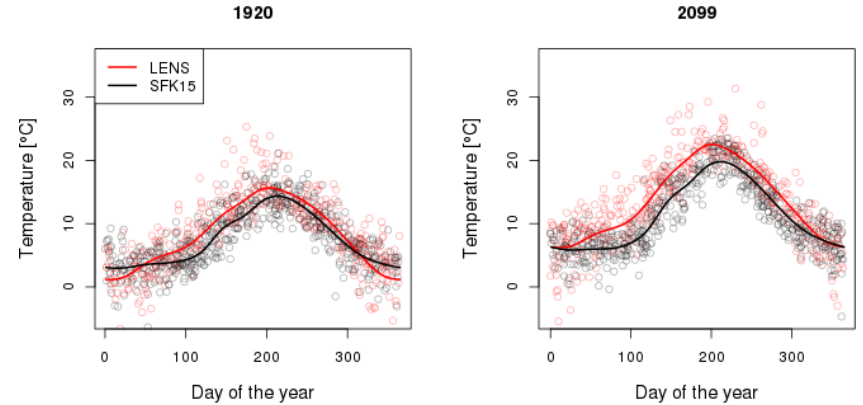
Figure 3. Example of quantile estimates fit to ensemble data, using daily mean temperatures in the years 1920 and 2099, at a grid cell containing Seattle, from LENS (red) and SFK15 (black). Solid lines are median quantile fits as a function of day of the year. Dots are ensemble output; for clarity we show only 3% of all data, sampled randomly.